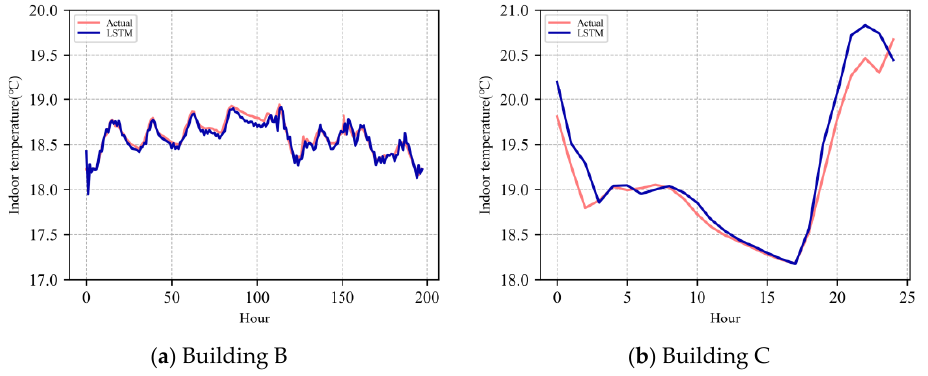
Figure 9. Comparison between LSTM and SMI in building A.